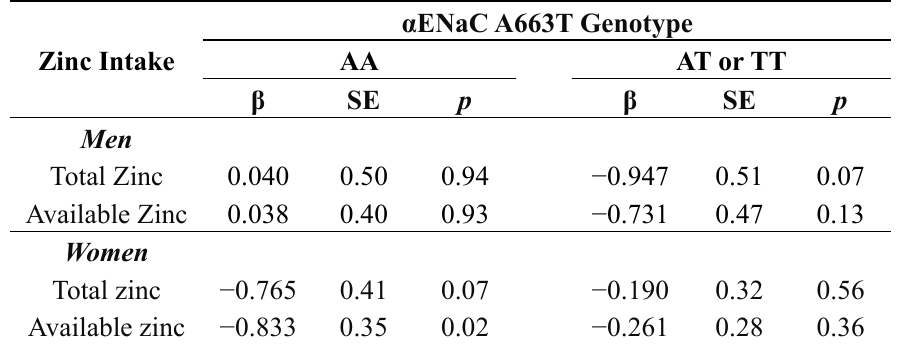
Table 4. Association between salty taste threshold and zinc intake according to α ENaC A663T polymorphism in men and women a